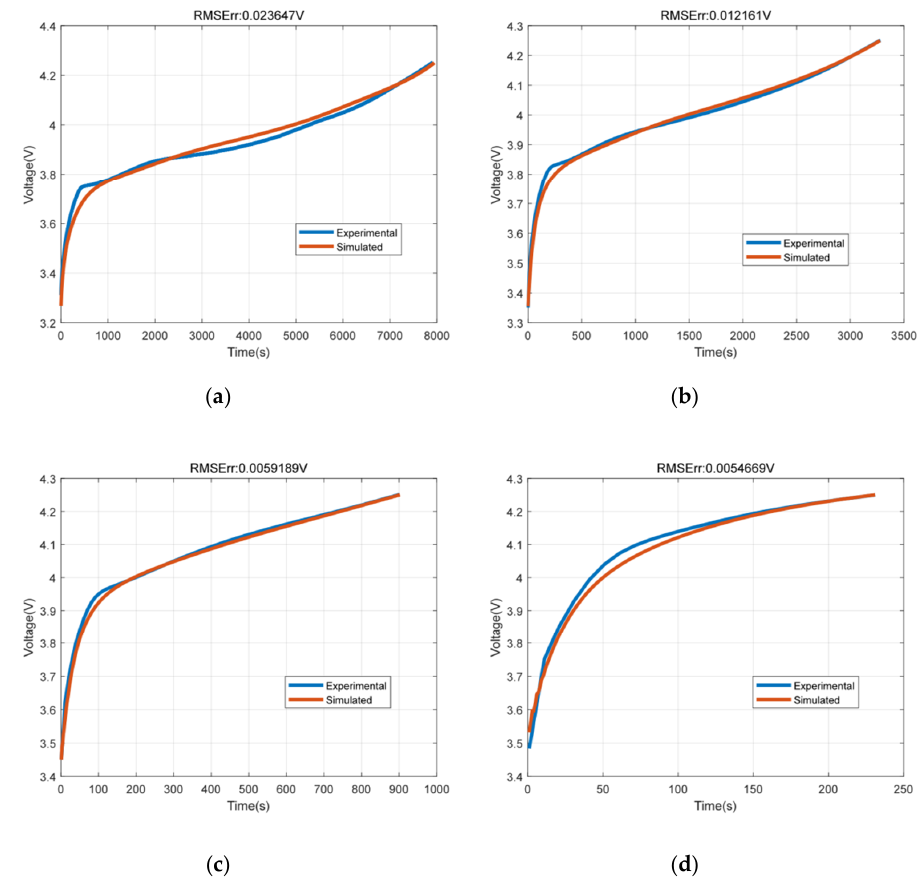
Figure 4. The terminal voltage fitting results under the four charging currents. ( a ) Terminal voltage at 0.5C; ( b ) Terminal voltage at 1C; ( c ) Terminal voltage at 2C; ( d ) Terminal voltage at 3C.